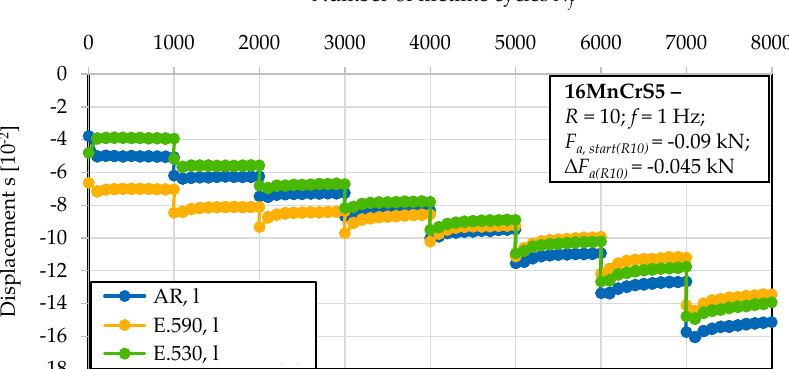
Figure 5. Material reaction under cyclic compression load conditions obtained longitudinal to, viz. in, the extrusion direction (l) after the load increase test (LIT).